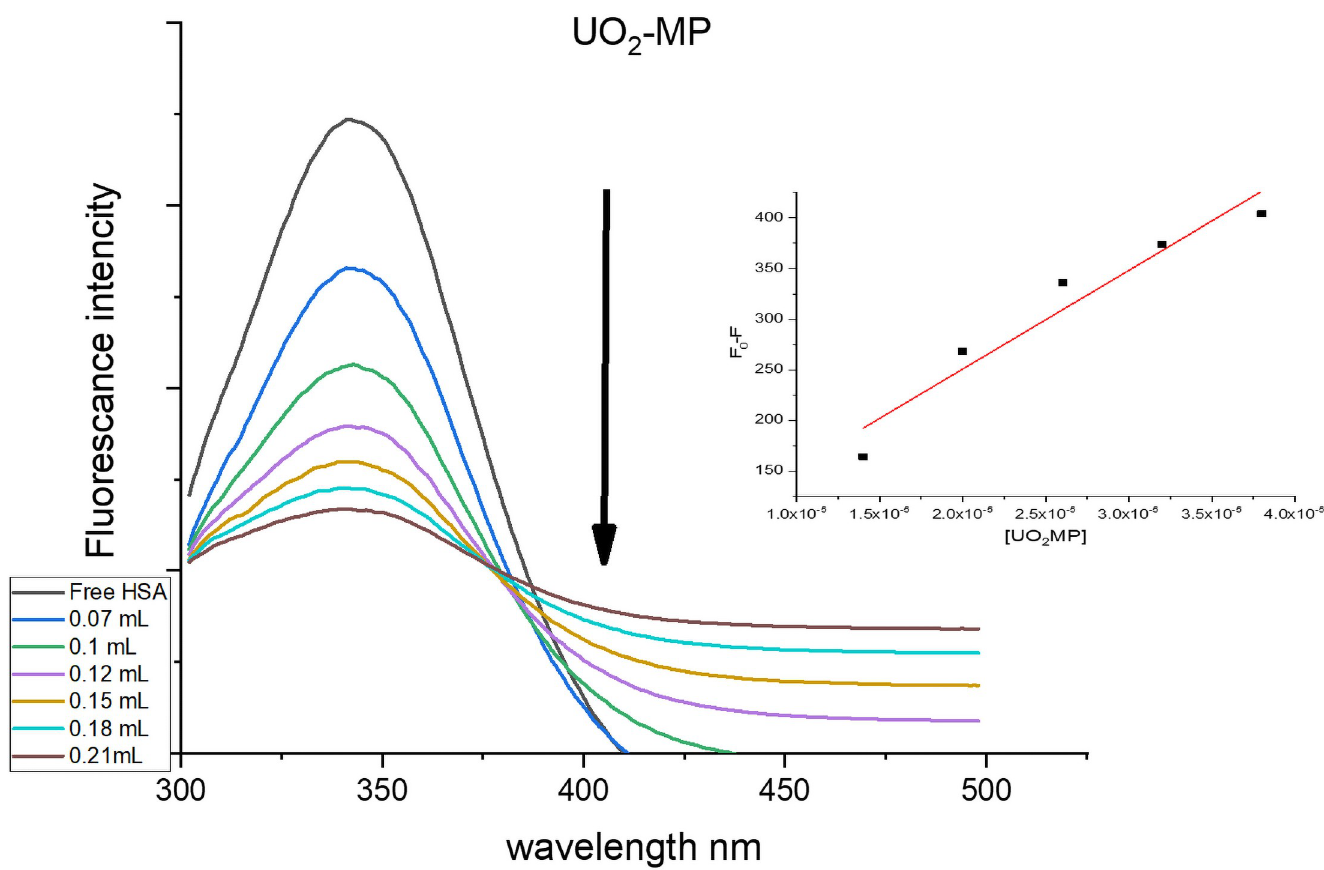
Fig 10. Emission spectrum of [(UO 2 )(OAc)2(MP)] complexes bound to HSA in the presence and absence of the complexes. Inset shows the plots of emission intensity I 0 /I vs. [Complex] for determining K SV